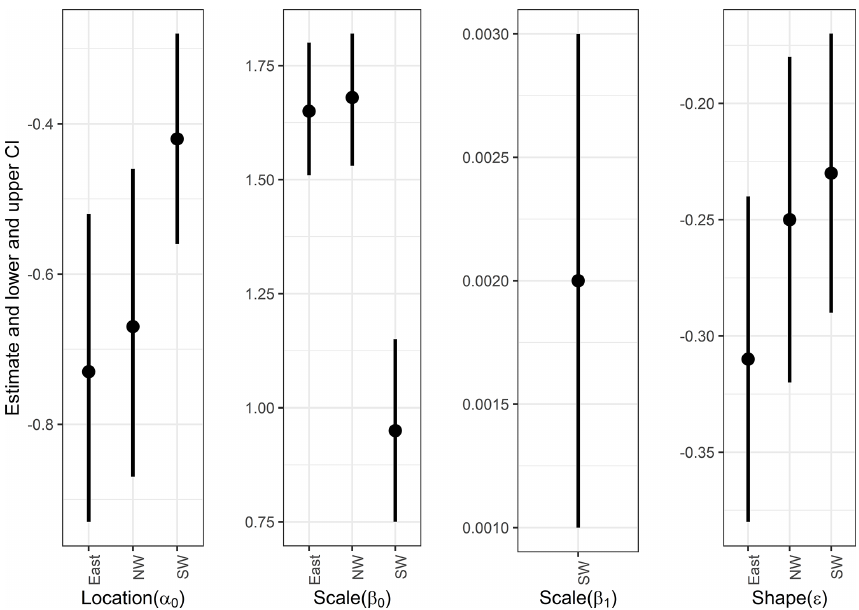
Figure 4. The 95% confidence intervals of parameters based on the normal approximation for each parameter. Also numerical values are listed in Table S1.